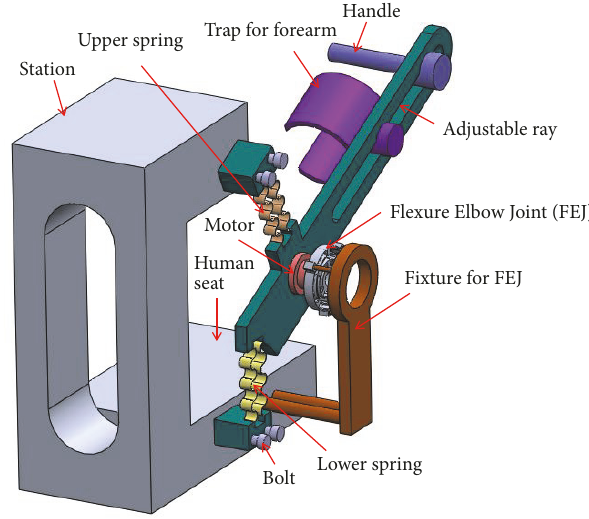
Figure 6: 3D model of the upper-limb assistive